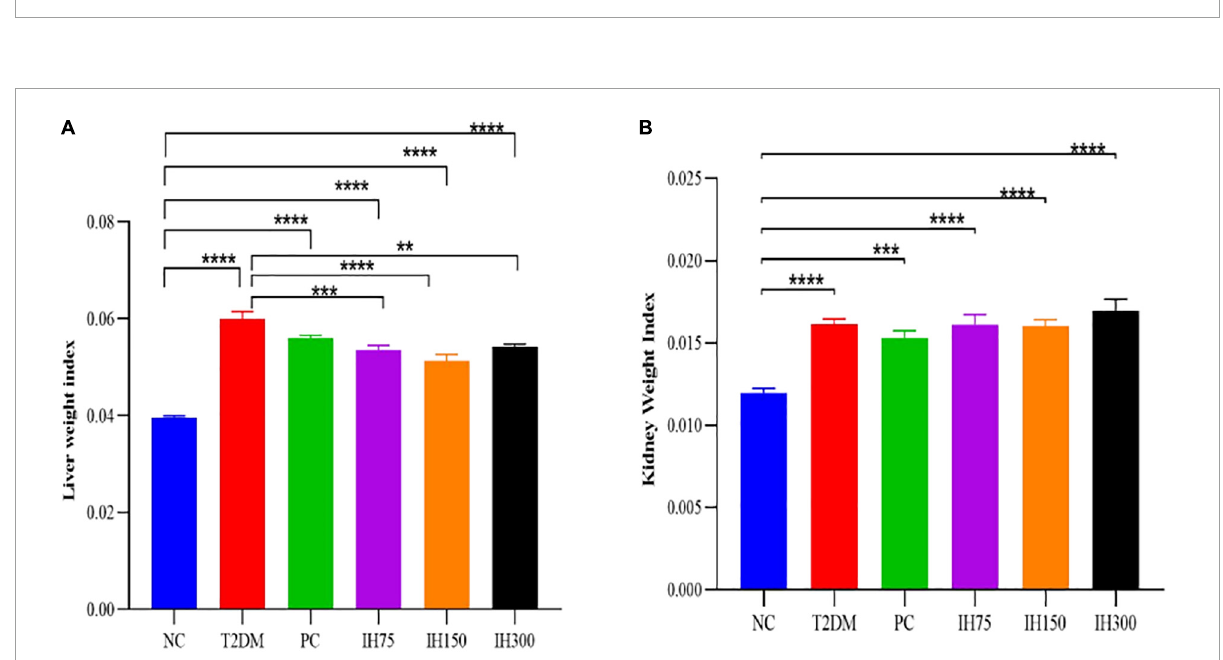
FIGURE2 Effect of IH on serum triglycerides (TG) (A) , cholesterol (CHO) (B) , high density lipoprotein cholesterol (HDL-C) (C) , low density lipoprotein cholesterol (LDL-C) (D) , and interleukin (IL)-1 β (E) in mice. All data are expressed as mean ± standard error of the mean (SEM). N = 6, P < 0.05 (*), P < 0.01 (**), and P < 0.001 (***).